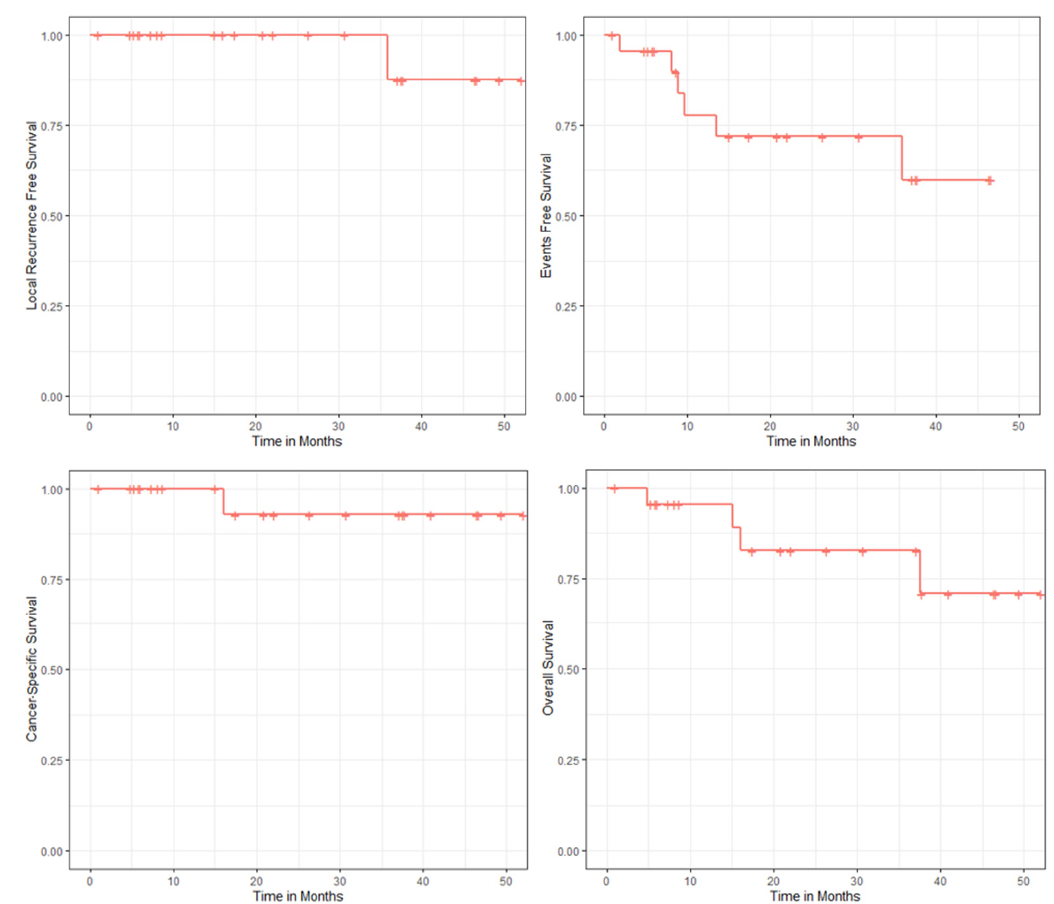
Figure 2. Kaplan–Meier estimates of local recurrence-free survival; event-free survival; cancer-specific survival and overall survival.